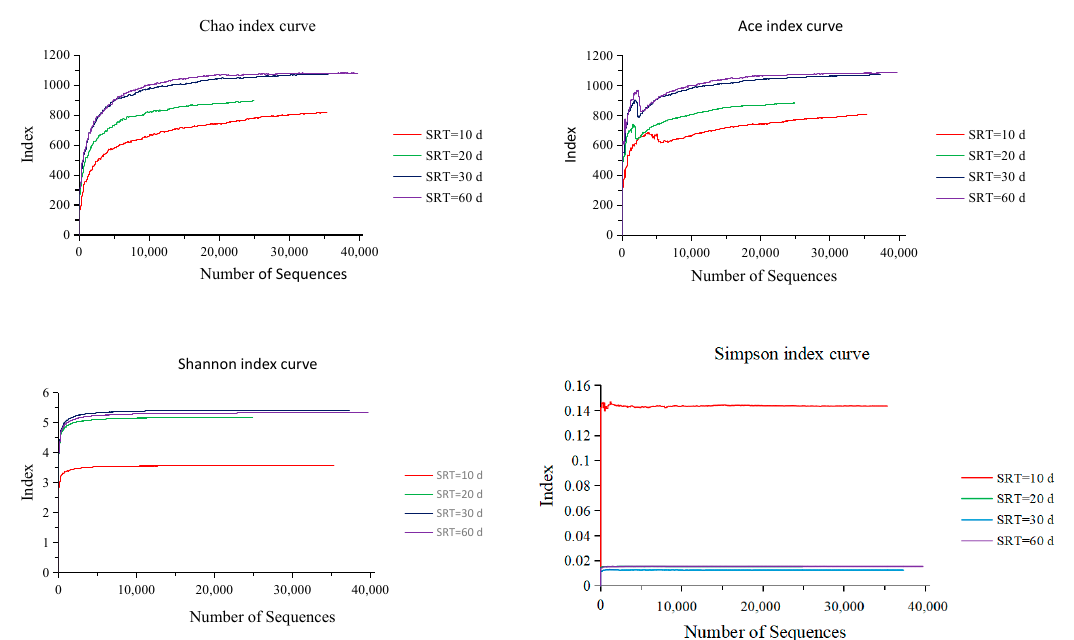
Figure 5. Microbial alpha diversity in activated sludge under the four different SRT